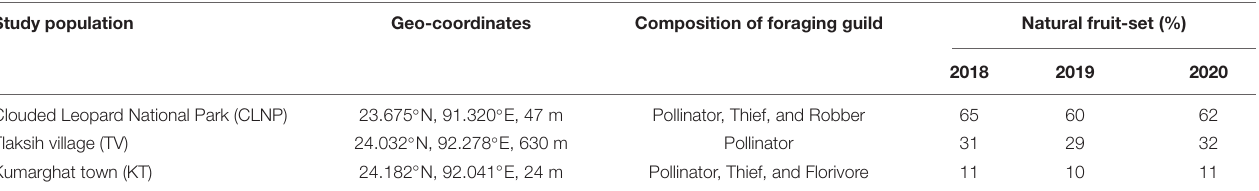
FIGURE 1 | Floral visitors in Aerides odorata . (A) A flowering patch near Tlaksih Village. The flowers are arranged in pendulous racemes. Inset: A freshly opened flower with shiny-green forward facing hooked spur (scale = 1 cm). (B) Xylocopa nasalis pollinating the flower. (C) Macroglossum belis thieving on the flower. (D) The florivore, Anoplolepis gracilipes (white circle), is involved in the removal of the spurred nectary tip (red circle), (E) Paratrechina sp. (white circle) acts as a robber by piercing the nectary (red circle). TABLE 1 | Location, foraging guilds, and natural fruit-set pattern in the three study populations. Study population Geo-coordinates Composition of foraging guild Natural fruit-set